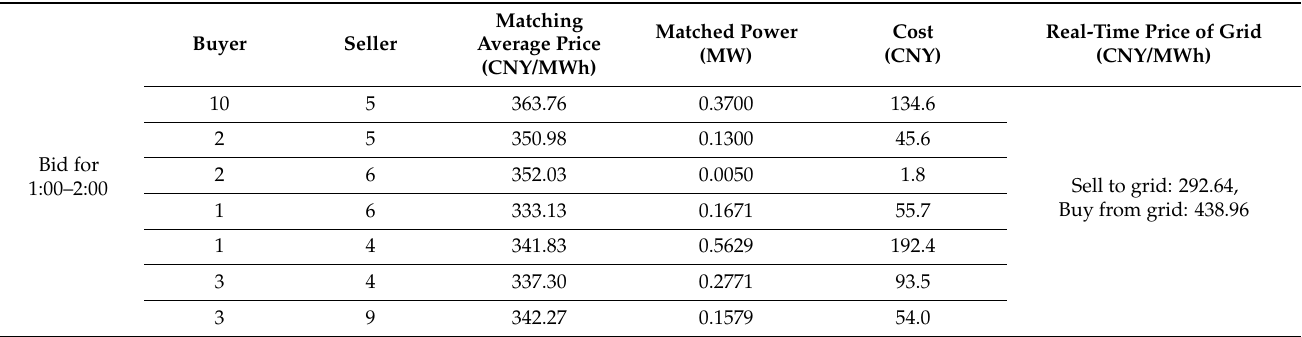
Table 8. The matching result for the first bidding stage at 1:00–2:00 on the scenario of prosumer 4 and 8 as aggregator